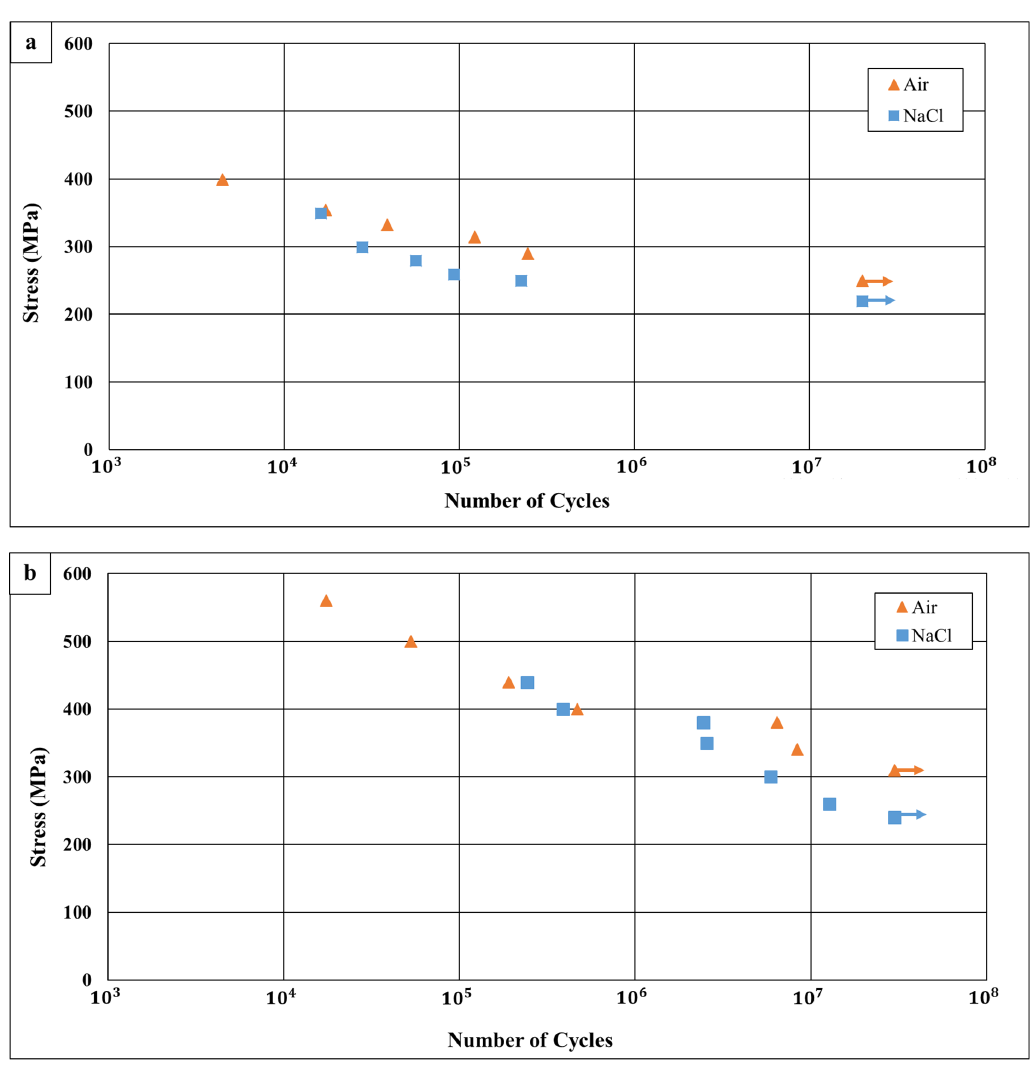
Figure 10. S-N curves obtained in air and in 3.5% NaCl solution. ( a ) WLAM 316L alloy. ( b ) Counterpart AISI 316L alloy.